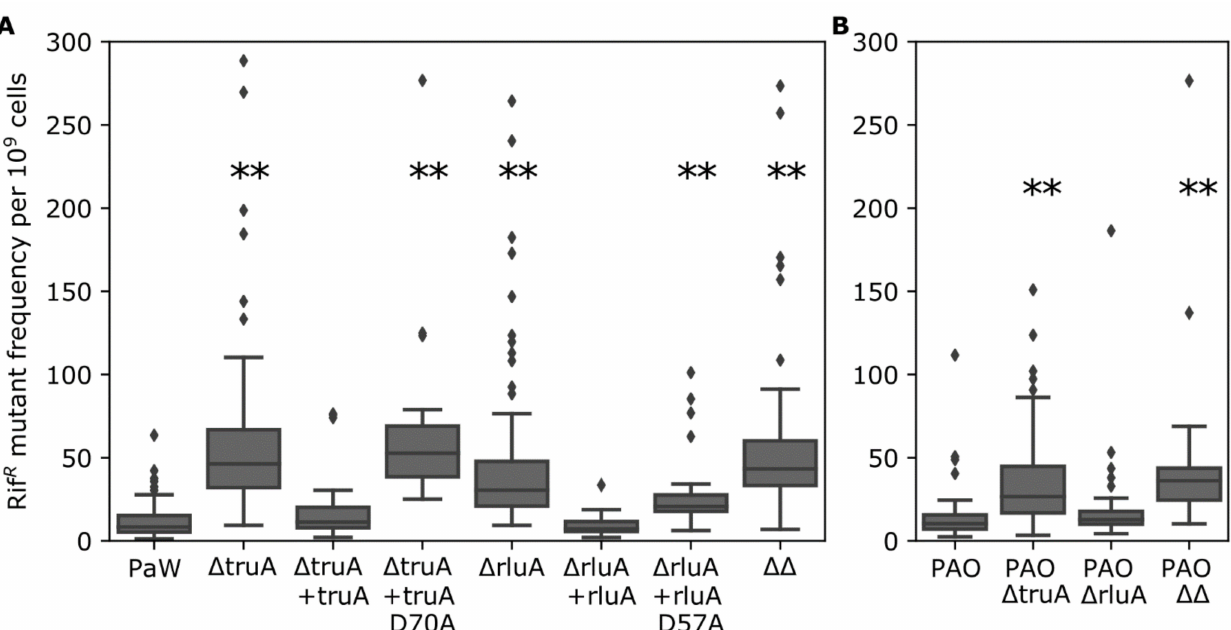
Figure 2. Comparison of Rif R mutant frequencies of wild-type P. putida PaW85 and truA and rluA deletion strains ( A ) or wild-type P. aeruginosa PAO1-L and truA and rluA strains ( B ). The mean values (line in the box) of Rif R mutant frequencies per 10 9 cells are presented. The upper and lower borders of box represent third and first quartile, respectively, the whiskers represent non-outlier range and dimonds indicate outliers. In each strain n ≥ 40. ∆ truA + truA/ ∆ rluA + rluA—deletion strain complemented with functional gene; ∆ truA + truAD70A/ ∆ rluA + rluAD57A—deletion strain complemented with catalytically inactive TruA or RluA, respectively; ∆∆ —strain lacking both truA and rluA . “**” indicate p -value < 0.001 compared to the respective